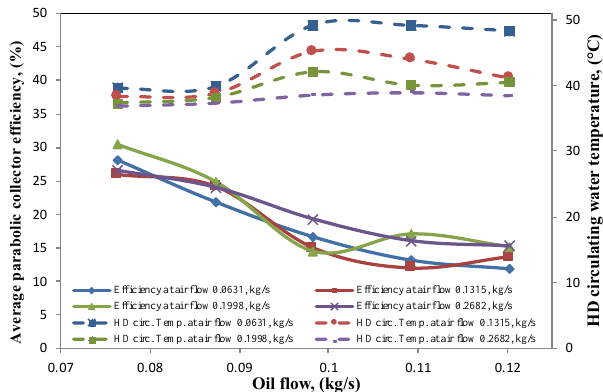
Figure 21. Average collector efficiency at different air and oil flow rates.